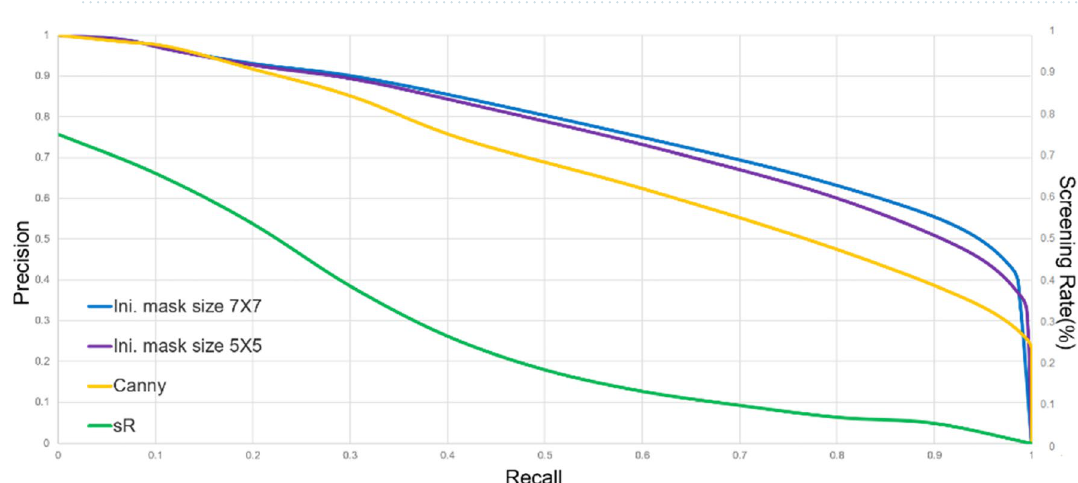
Figure 11. PR Curves of our method using initial mask size of 7*7 and 5*5. Yellow curve is for Canny detector.